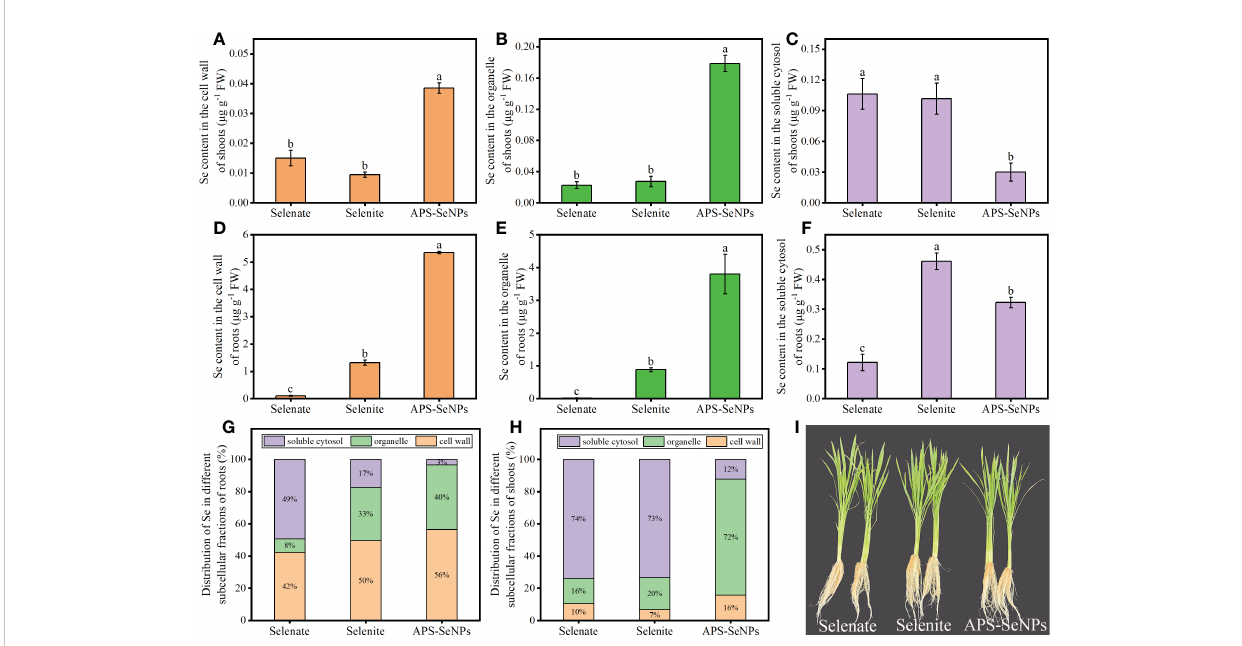
FIGURE 7 (A – F) Selenium (Se) contents of the cell wall, organelle, and soluble cytosol in rice shoots (A – C) and roots (D – F) under different Se treatments. (G, H) Se distribution in the subcellular fractions of roots (G) and shoots (H) . Data are presented as the mean ± SE ( n = 4). Different letters indicate signi fi cant differences between treatments at p < 0.05 according to Duncan ’ s